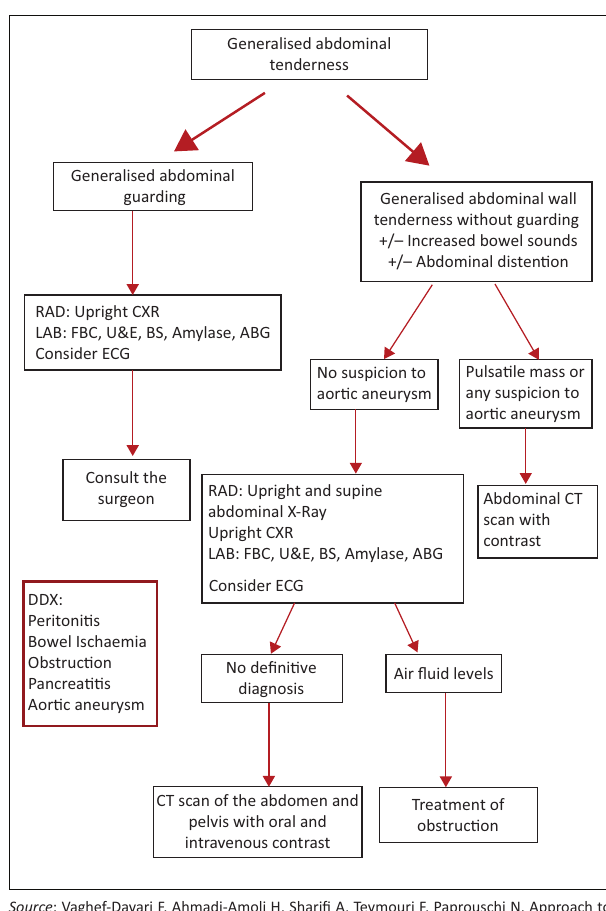
FIGURE 2: Generalised abdominal pain